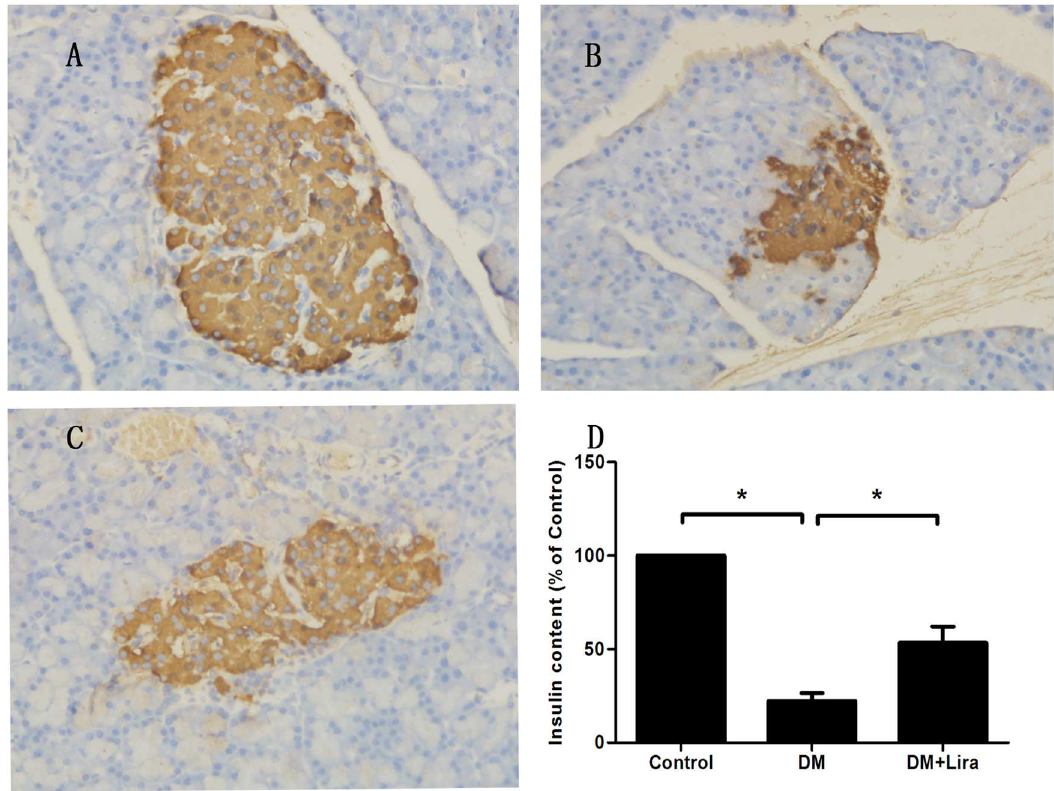
Fig 1. Immunohistochemicalstaining of insulin from the control group (A), DM group (B), and DM + liraglutide group (C). Islet-positive regions are brown. Fig 1D shows the relativeinsulincontent of the three groups. Diabeticrats were dividedinto two groups, administered without (DM group) or with liraglutide(DM + Lira group) at a dose of 200 μ g/kg/ d. SD rats of control group were fed with normal chew and receivedsubcutaneous injectionof saline (Controlgroup, DM group, and DM + liraglutidegroup; 100%, 22.3 ± 4.2%, 55.3 ± 8.7%, n = 5, p <